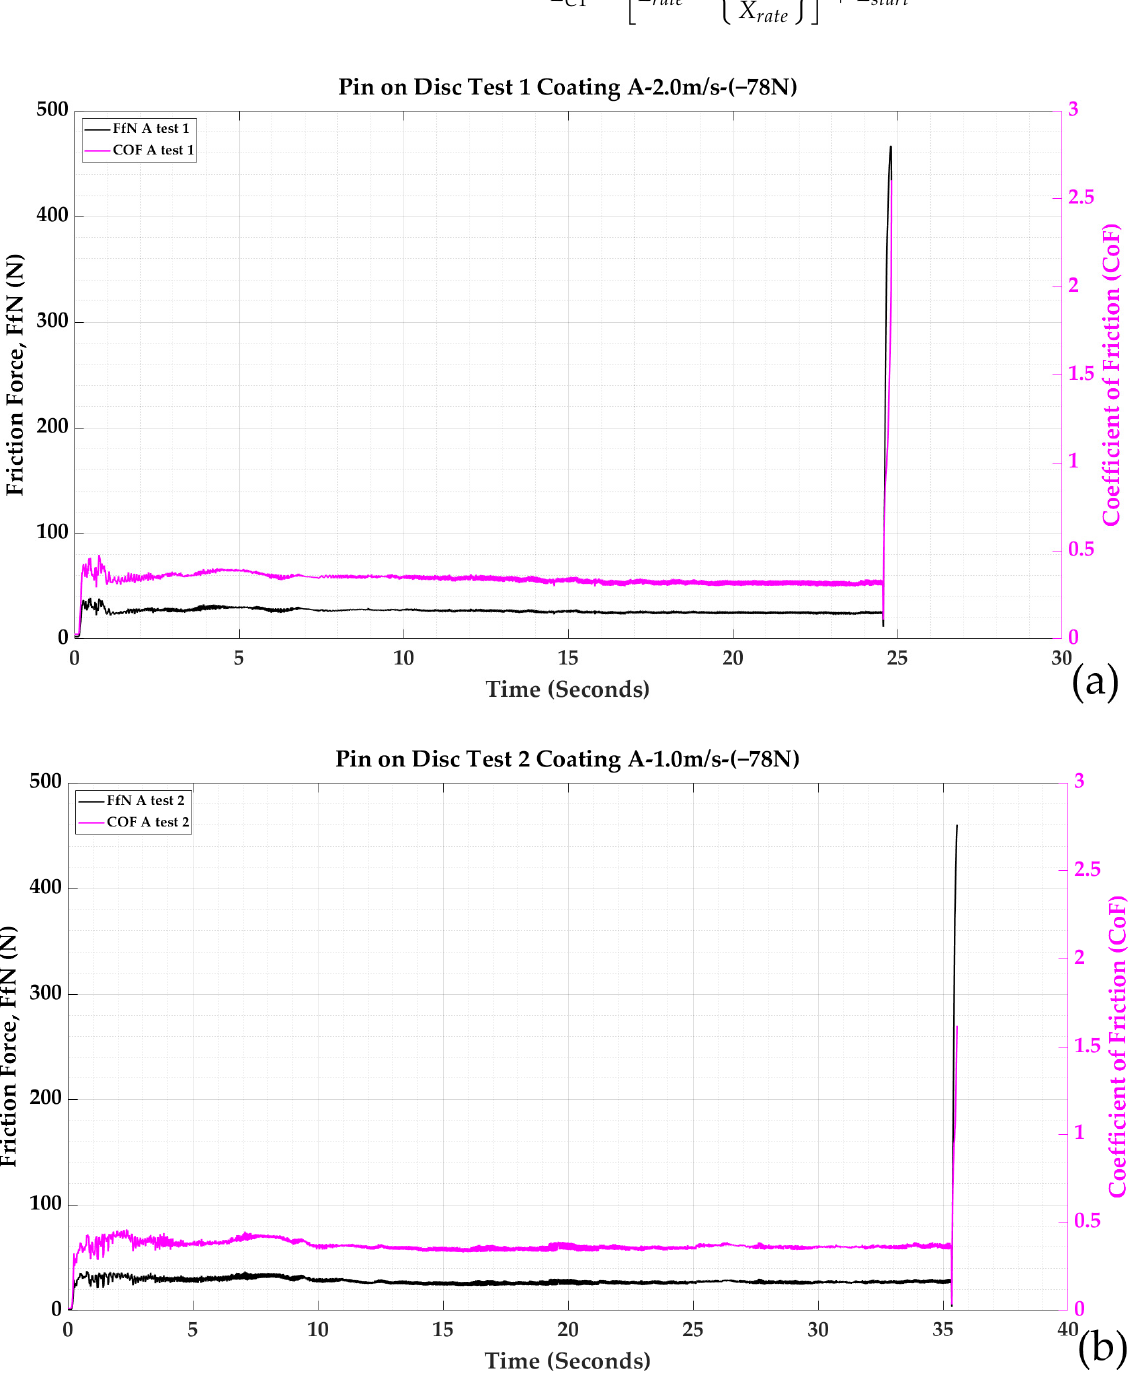
Figure 3. Friction coefficient plot vs. time (seconds) vs. friction force (N): ( a ) Test 1a and ( b ) Test 2a for Coating A.